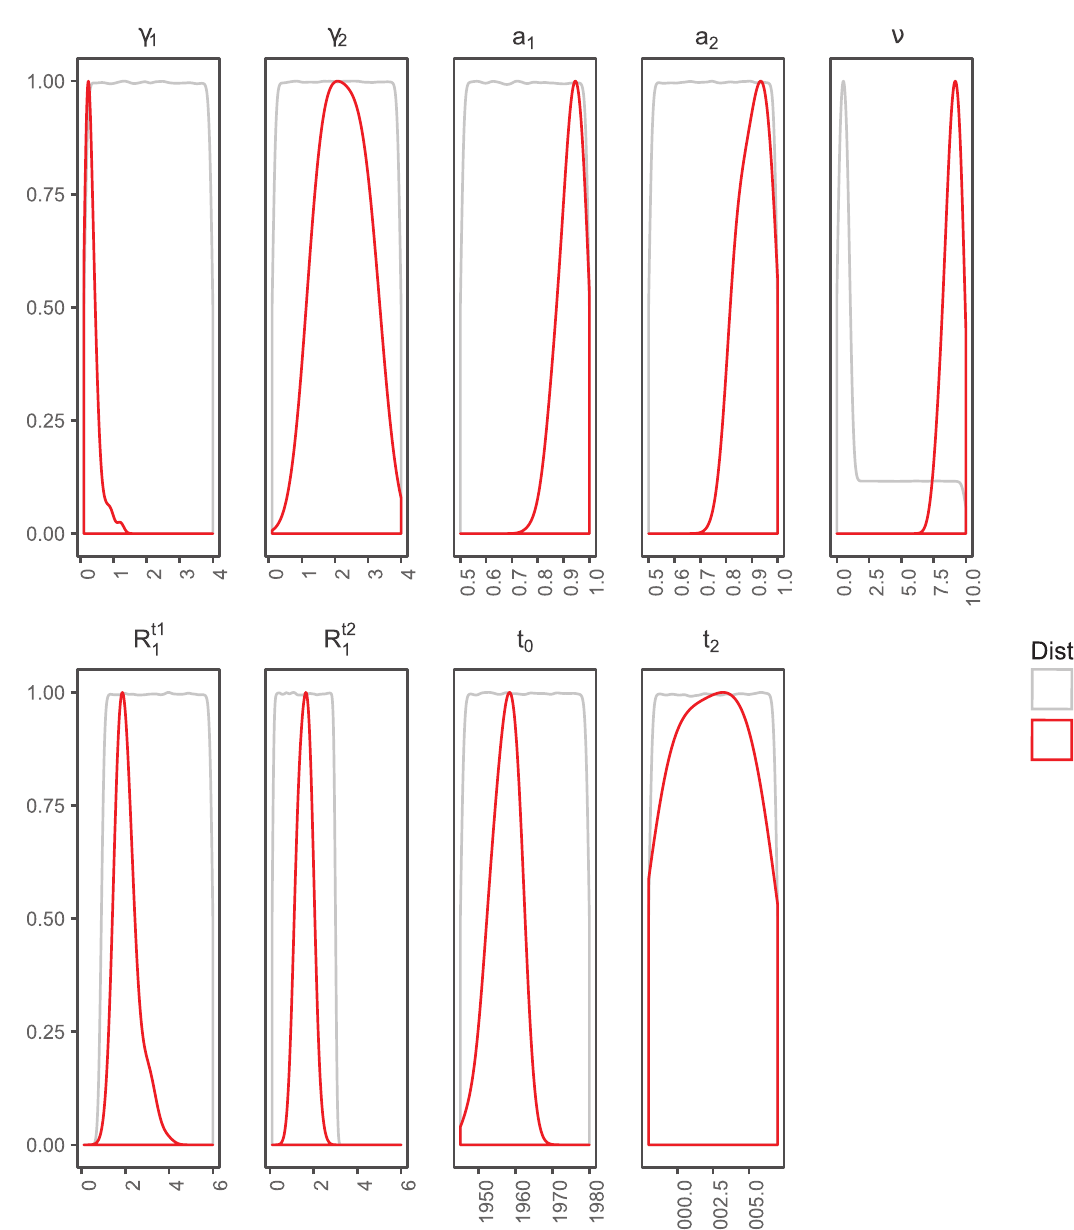
Fig 2. Parameter prior and posterior distributions. Prior distributions are in grey and posterior distributions inferred by ABC are in red. The thinner the posterior distribution width, the more precise the inference. Posterior distributions are truncated based on the prior distribution. The parameters γ 1 and γ 2 are the end of infectiousness rates for non-MSM and MSM hosts respectively. The parameters a 1 and a 2 are the assortativity levels between hosts types, for non-MSM and MSM hosts respectively. ν is the transmission rate differential between non-MSM and MSM hosts. The parameters R t 1 and R t 2 are respectively the reproduction numbers for the non-MSM hosts before and after the introduction of the third-generation 1 1 HCV tests in 1997. The t 0 parameter is the origin of the epidemic in non-MSM hosts, and t 2 is the origin of the epidemic in MSM hosts. the third-generation HCV test in 1997. The inference on the differential transmission parame- ter indicates that HCV transmission rate is ν = 9.0 [7.7; 9.9] times greater from MSM hosts than from non-MSM hosts. By combining these results (see the Material and methods), we compute the effective reproduction number in MSM hosts and find R ð 2 Þ ; t 3 ¼ 1 : 73 ½ 1 : 03; 4 : 32 � .